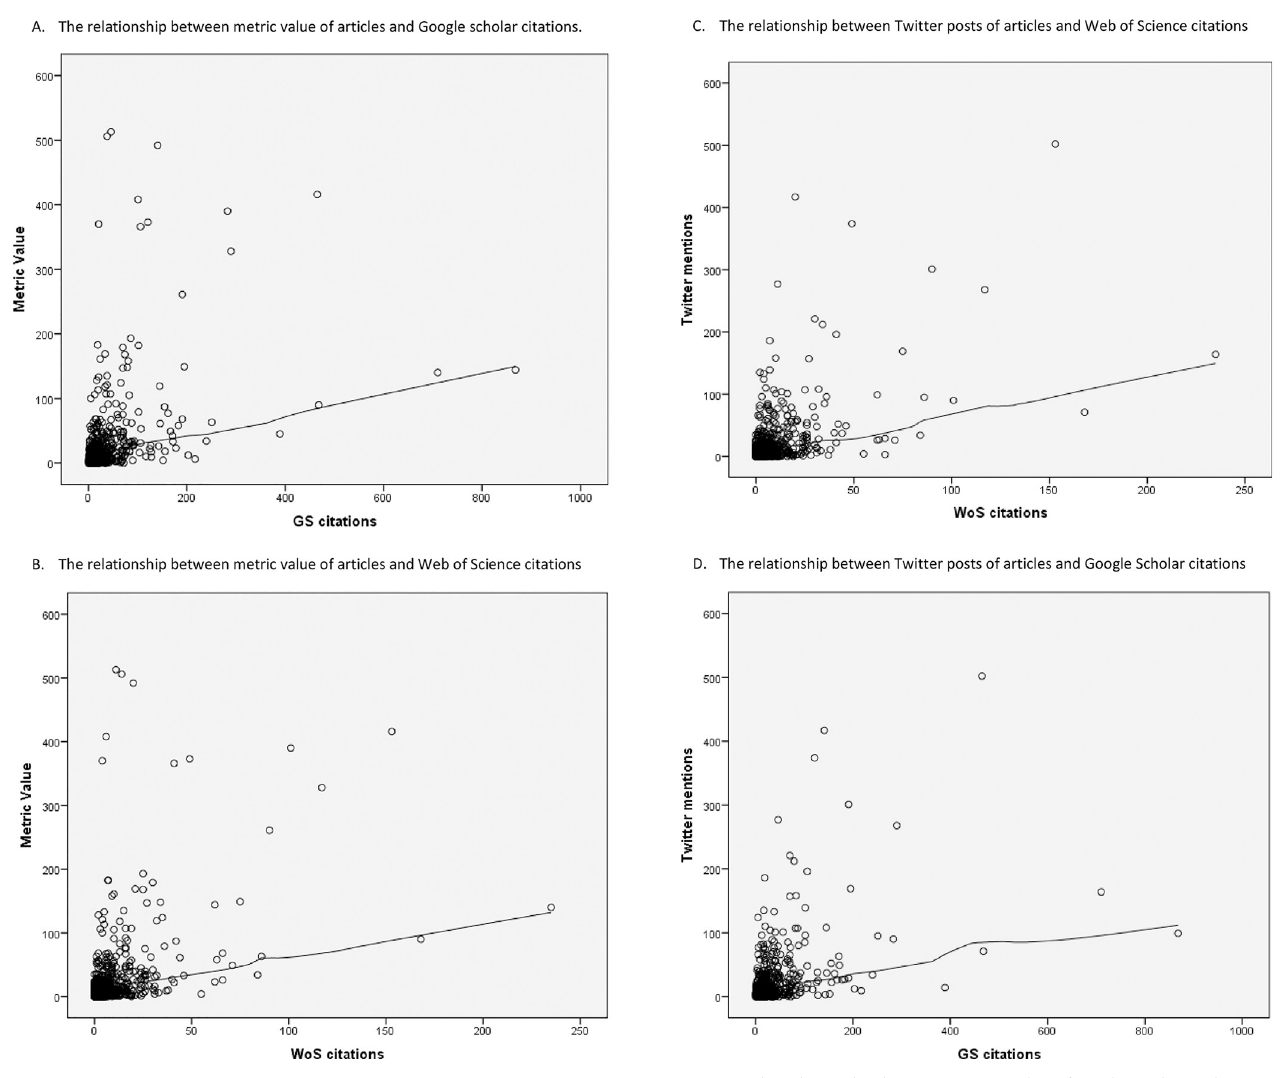
Fig 1. The correlation between citation of articles, and metric value and Twitter posts. A. The relationship between metric value of articles and Google scholar citations. B. The relationship between metric value of articles and Web of Science citations. C. The relationship between Twitter posts of articles and Web of Science citations. D. The relationship between Twitter posts of articles and Google Scholar